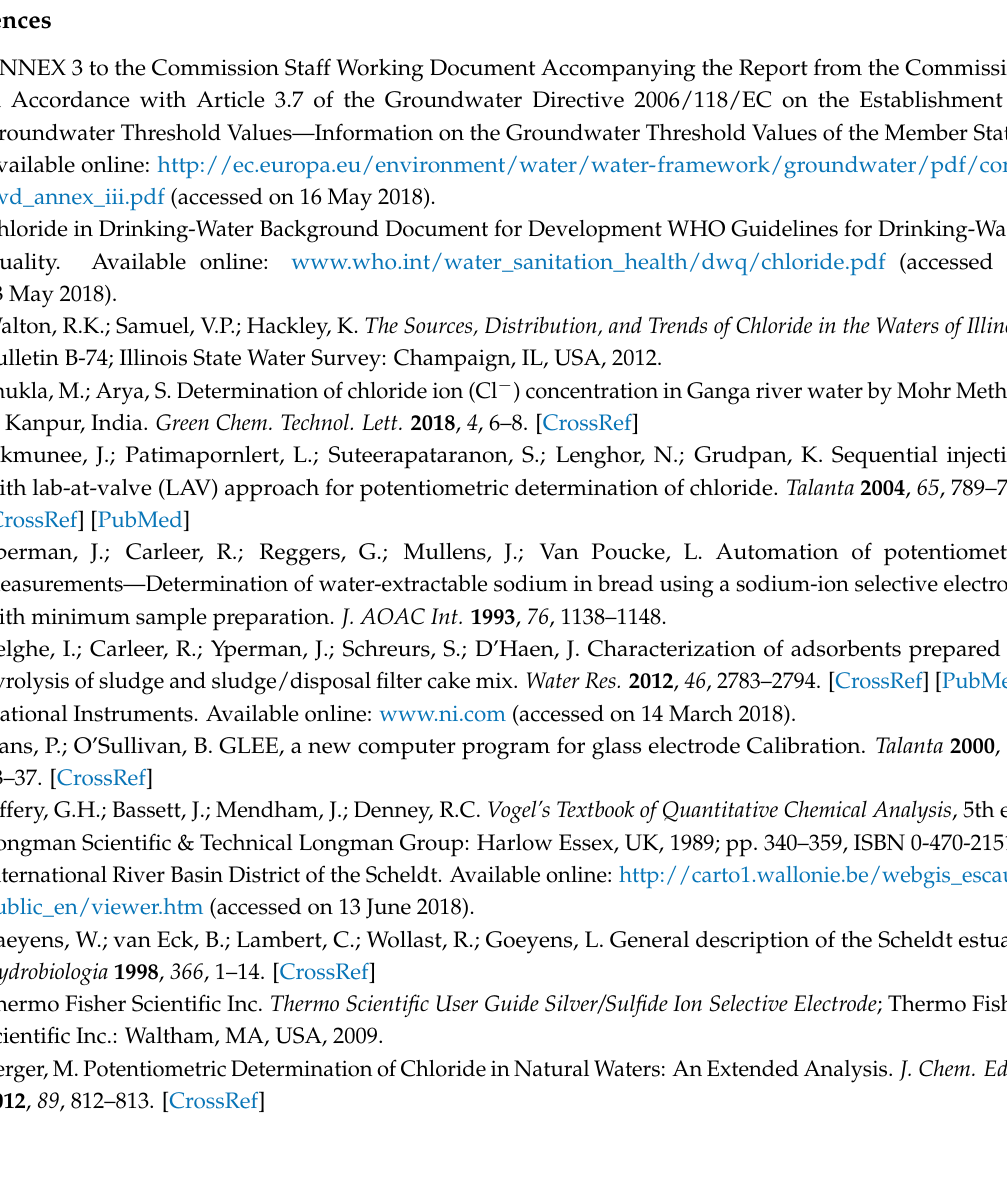
Figure S1: Computer configuration, Figure S2: A cryostat, type Polyscience Digital Temperature Controller (model 9110), Figure S3: Electronic diagram of the PT1000, Schott type W 5780 NN ( top ); the A/D converter on the NI PCI-6220 DAQ Board ( bottom ), MS Office Excel S1: OVERVIEW_TITRATIONS_FINAL_Guedens &